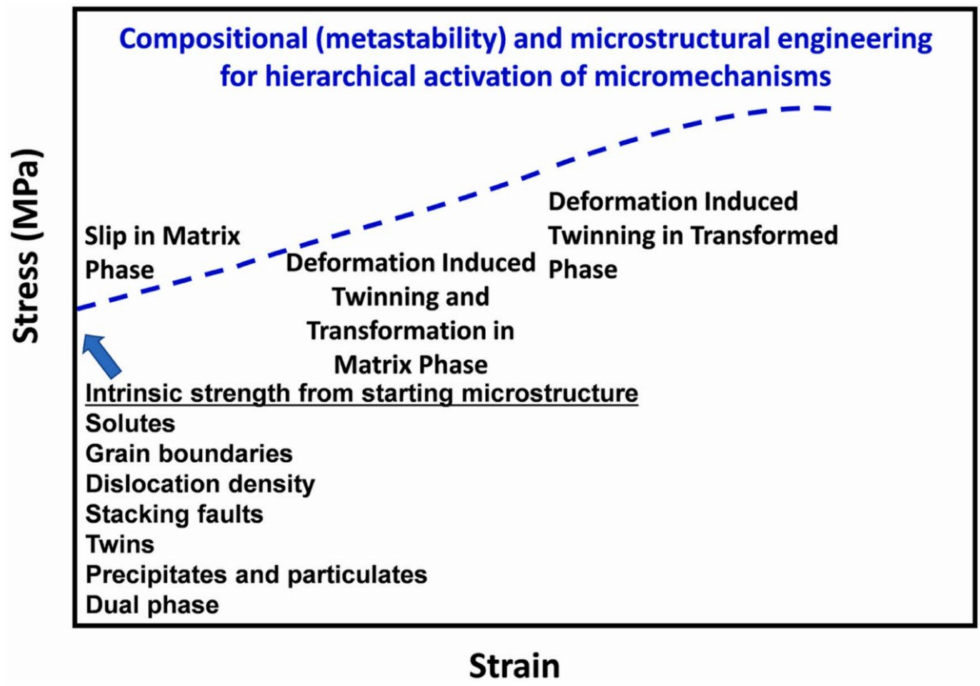
Figure 1. Hypothetical stress-strain curve of HEAs’ design approach by employing micromechanisms induced by composition and structure. Adapted from